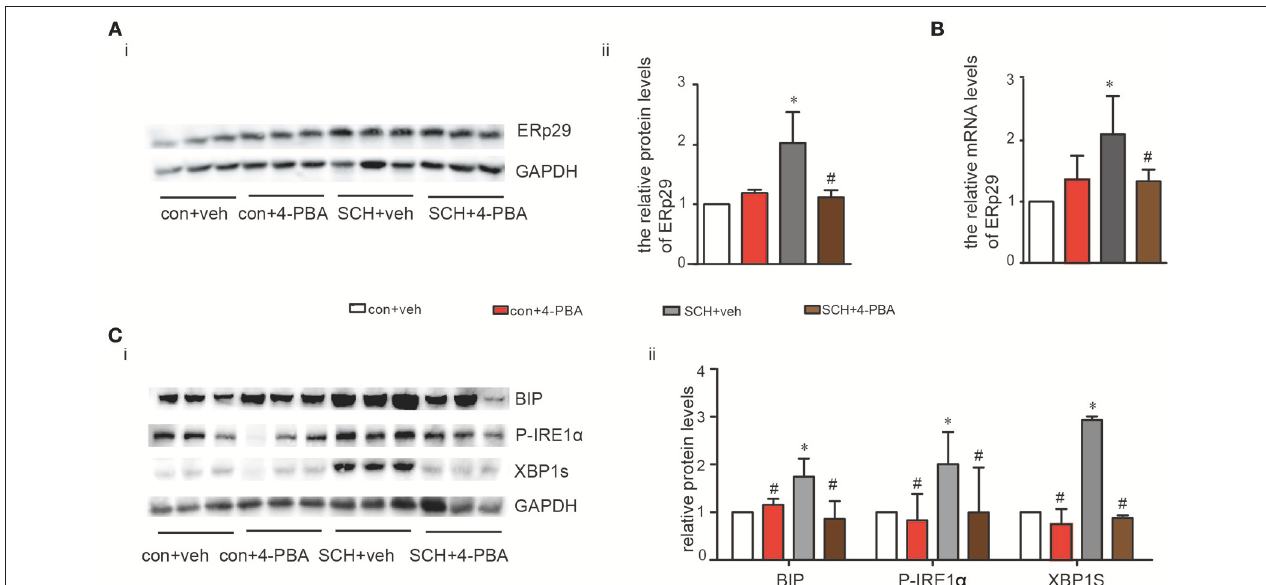
FIGURE 4 | 4-PBA alleviated hepatic ERS in SCH mice. We established SCH mouse model using MMI. When MMI was applied for 14 weeks, 4-PBA was given at a dose of 100 mg/kg · BW · d for 4 weeks, and mice were divided into four subgroups (as shown in Supplementary Figure 1 ): vehicle treated control mice group (con + veh group), 4-PBA treated control mice group (con + 4-PBA group), vehicle treated SCH mice group (SCH + vehicle group), and 4-PBA treated SCH mice group (SCH + 4-PBA group). (A) The protein expression of ERq29 was detected by western blot ( n = 4–6). (B) The mRNA expression of ERq29 was detected by Real-time PCR. (C) The expression of proteins in the Bip/IRE1 α /XBP-1 pathway were detected by western blot ( n = 4–6). The data are presented as the mean ± SD. * p < 0.05 compared with control. # p < 0.05 compared with